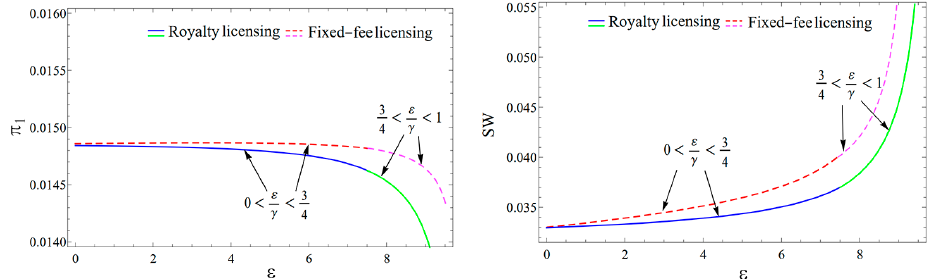
Figure 1. Optimal licensing strategies for patent holder in the absence of CSR